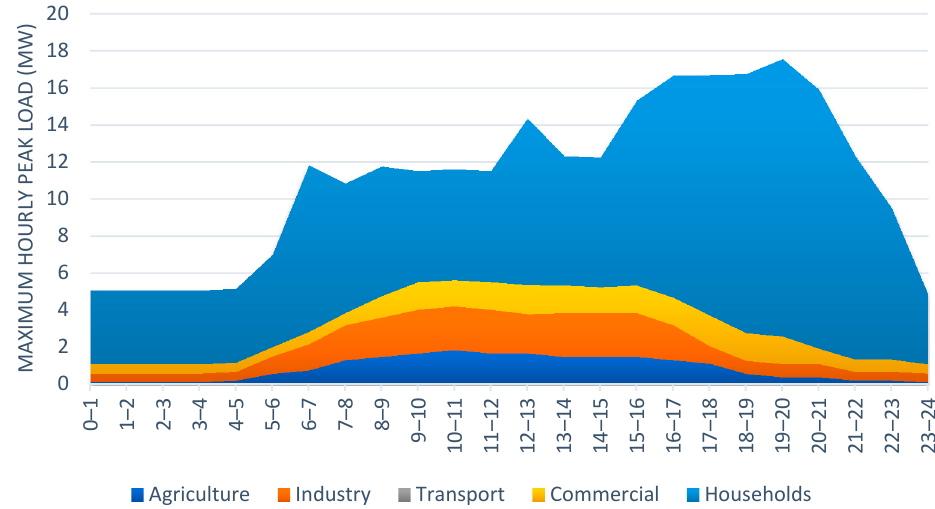
Figure 6. Hourly electricity consumption by sector in Isla de Juventud in January 2019. Data: [42]. The data on current electric power system represents the actual current set-up at Isla de la Juventud with a total installed capacity of 41.79 MW, [29]